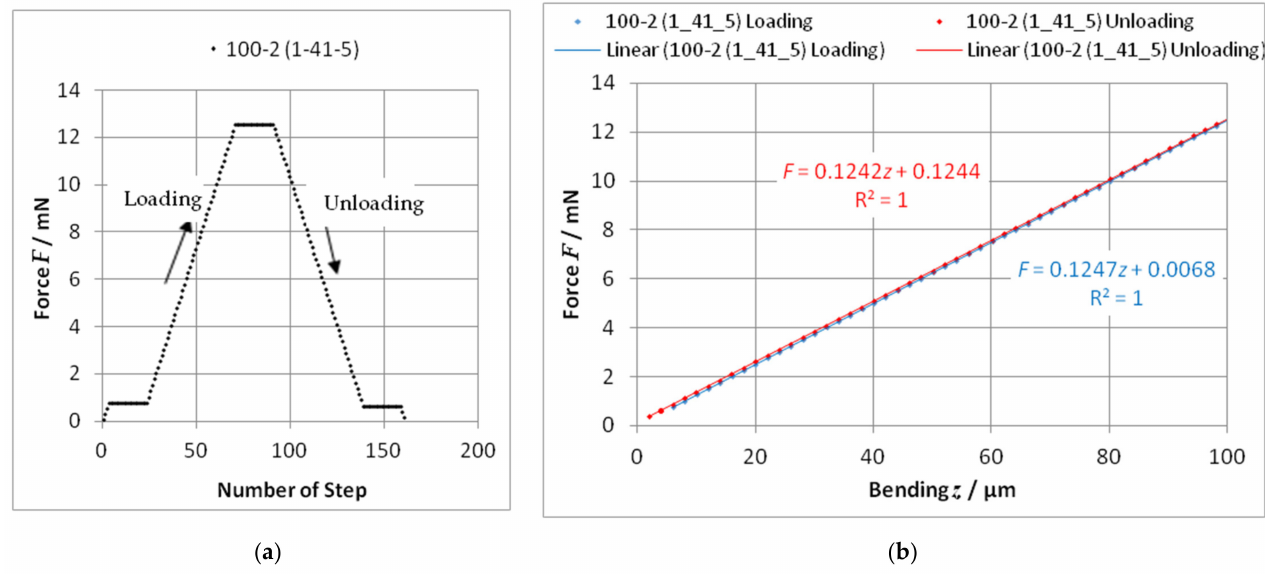
Figure 3. Plot of a force–bending characteristic: ( a ) Survey over the measuring sequence with 2 µ m steps (stop points at a small force and at the maximum force); ( b ) Determination of the stiffness c = F / z with linear trendlines. The specification of the cantilever 100-2 is given in Section 3.1; (1_41_5) means the 5th single